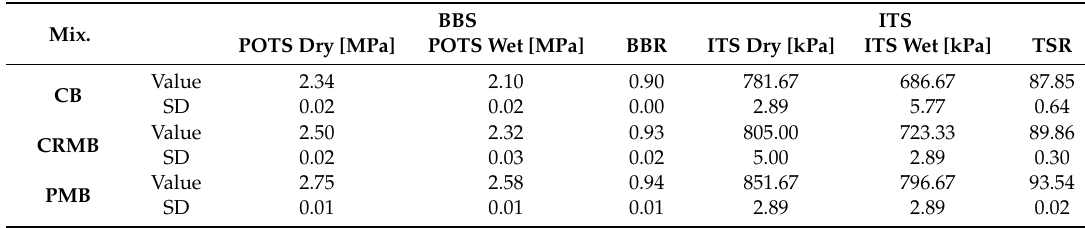
Table 7. Results of the BBS and Indirect tensile strength (ITS) tests.